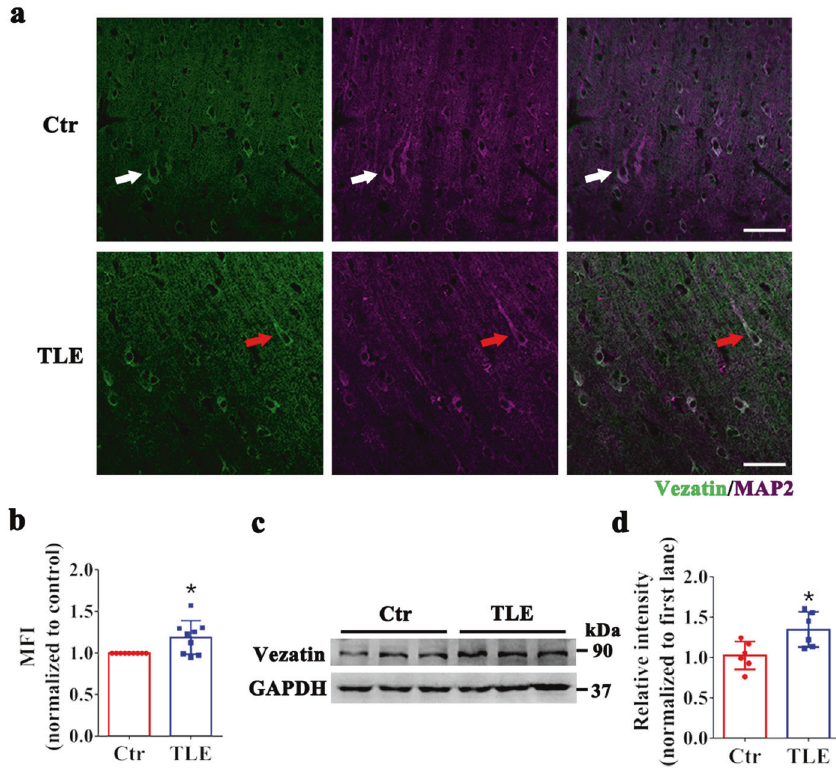
Fig. 7 The pattern of vezatin expression in subjects with epilepsy. a Representative images of immuno fl uorescence staining showing that in both the control group (white arrow) and TLE group (red arrow), vezatin (green) colocalized with the neuronal marker MAP2 (purple), and b the corresponding statistical analyses of the MFI of vezatin ( n = 9 per group, P = 0.023). c Representative images of western blots showing vezatin expression in the control group and TLE group and ( d ) the corresponding statistical analysis ( n = 6 per group, P = 0.017). Student ’